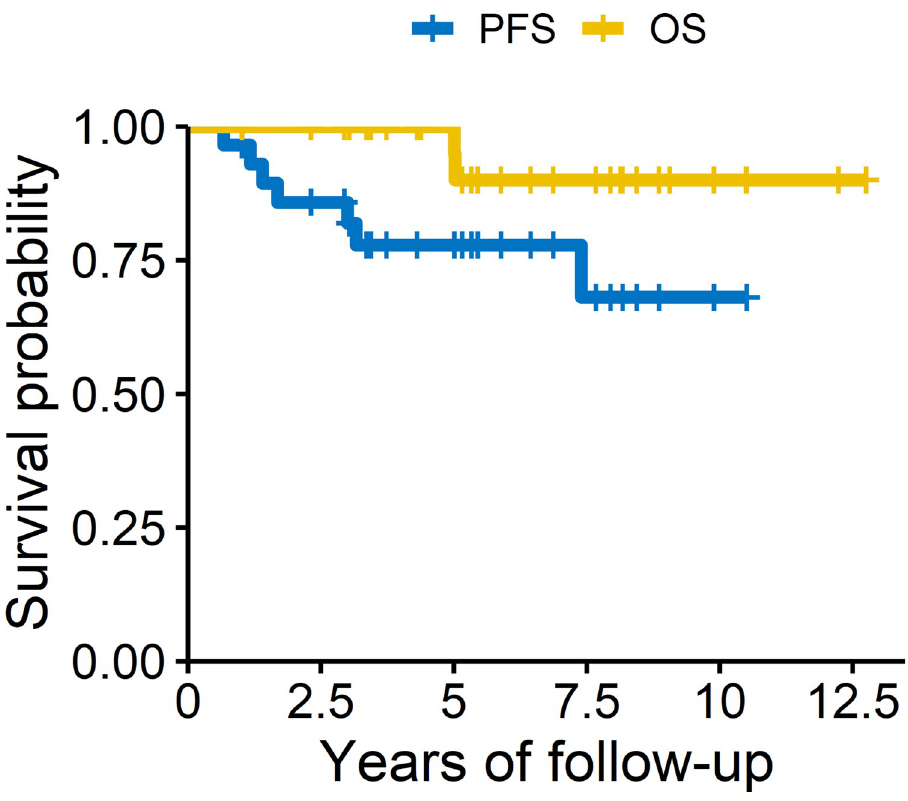
Fig 2. Progression-free survival and overall survival of the